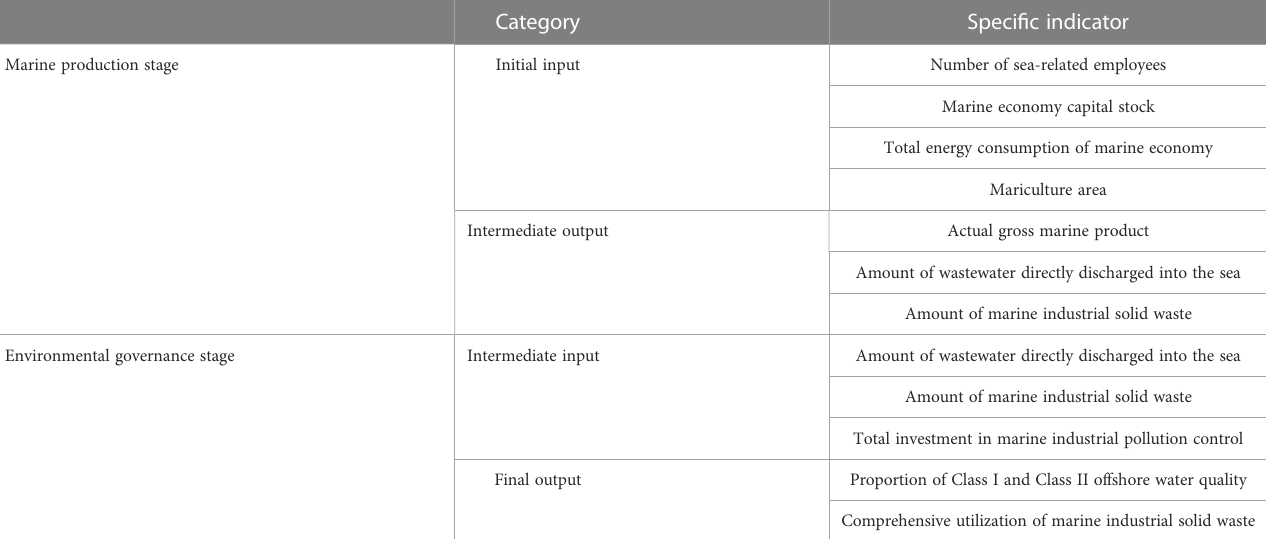
TABLE 1 Input-output indicators of marine green economy ef fi